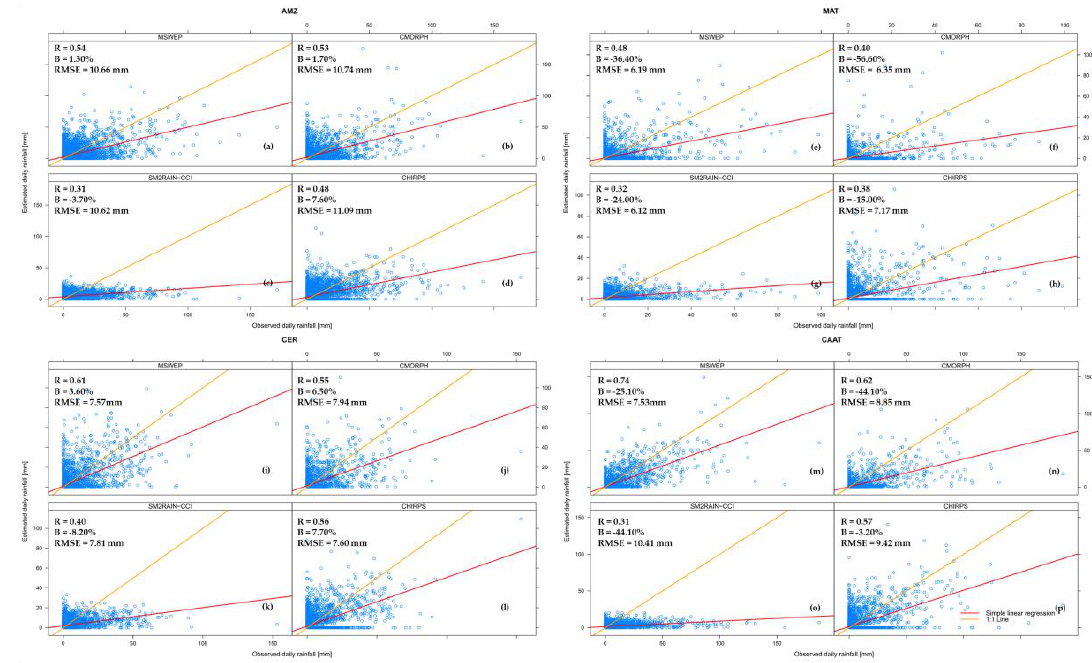
Figure 15. Daily rainfall estimates from rainfall products against in situ daily rainfall for each benchmark station shown in Figure 1a during the period 1998 – 2015: ( a – d ) Site: Zé Doca, Biome: AMZ;